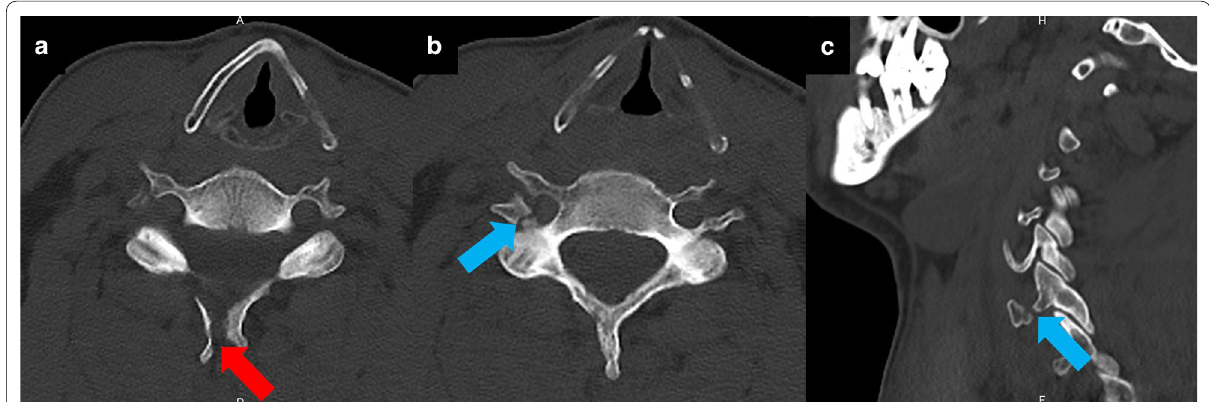
Fig. 1 Diagnostic error. A 48-year-old male patient was admitted to the ER with head trauma after falling from a height of 2 m. The on-call radiologist reported a displaced fracture at the spinous process of the C6 vertebra (red arrow, a ). Another displaced fracture at the posterior and lateral wall of the right transverse foramen of the C6 vertebra was missed (blue arrows, b , c ). Emergency physicians were informed about the fractures after a second review of CT images. CT angiography performed to rule out vertebral artery injury, revealed no vascular